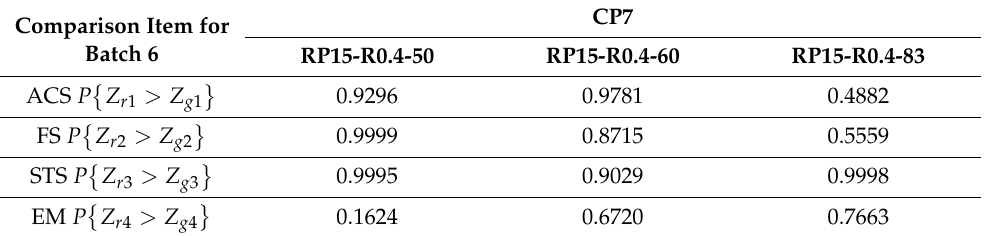
Table 12. Probability that the CVMC for steel fiber concrete is greater that of concrete used for batch 6. Comparison Item for